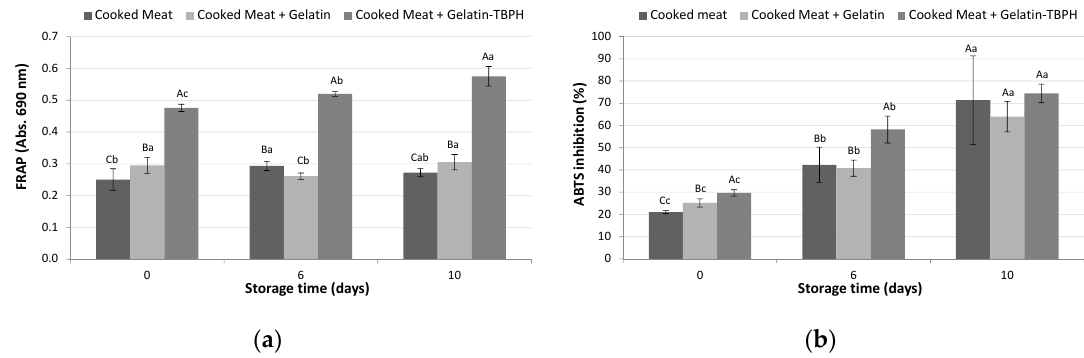
Figure 6. Antioxidant activity determined by ( a ) ferric reducing antioxidant power (FRAP) and ( b ) ABTS radical scavenging capacity of uncoated and coated meat samples during storage (0, 6, and 10 days) after cooking at 70 °C for 5 min. A capital letter indicates significant differences between samples within the same day of storage, whereas a lower case letter indicates significant differences between days of storage within the same sample ( p < 0.05).